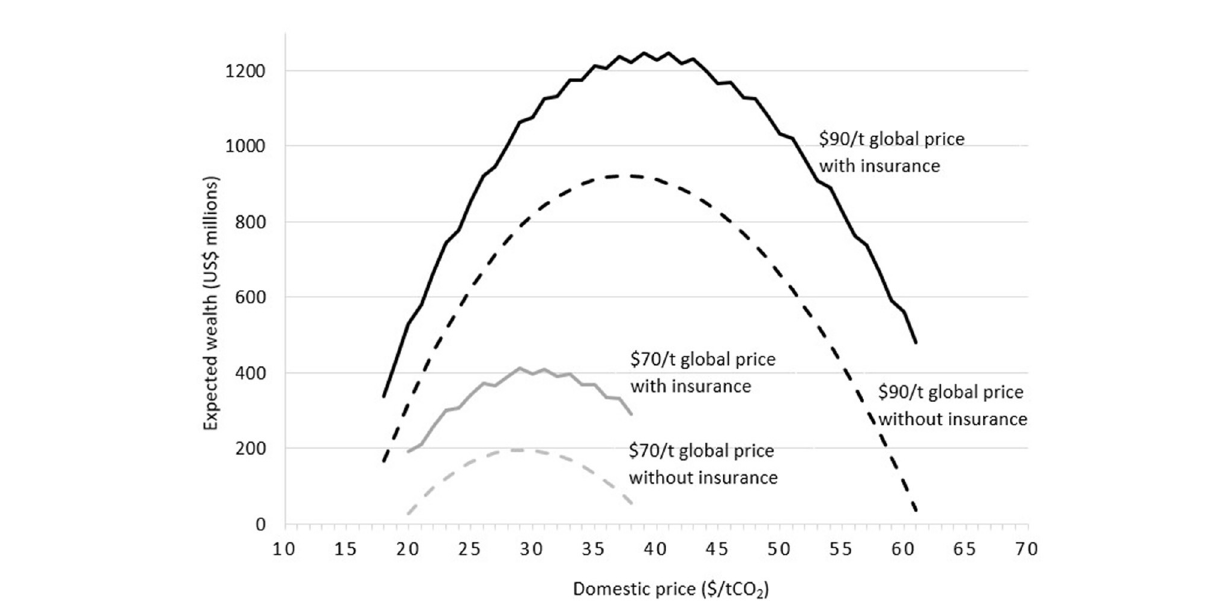
FIGURE6 Expected wealth with and without insurance, if jurisdiction fails to meet goal ( Q h ). Note: Vertical axis shows expected (probability-weighted) wealth of jurisdiction. Assumed minimum abatement requirement ( Q ) equals 35 million tCO 2 such that international payments are only made for abatement exceeding that level.